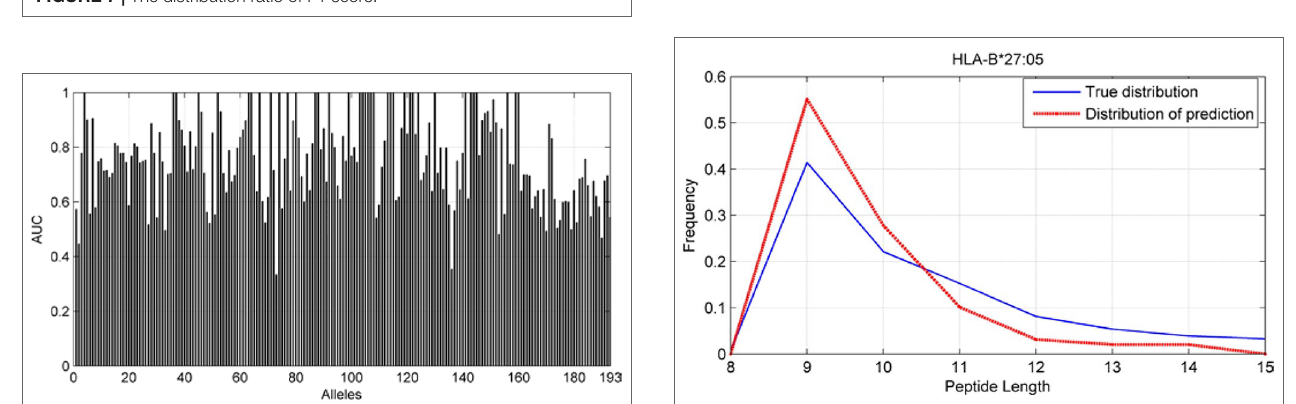
FIgURe 11 | Predicted length preference of HLA-B*27:05.